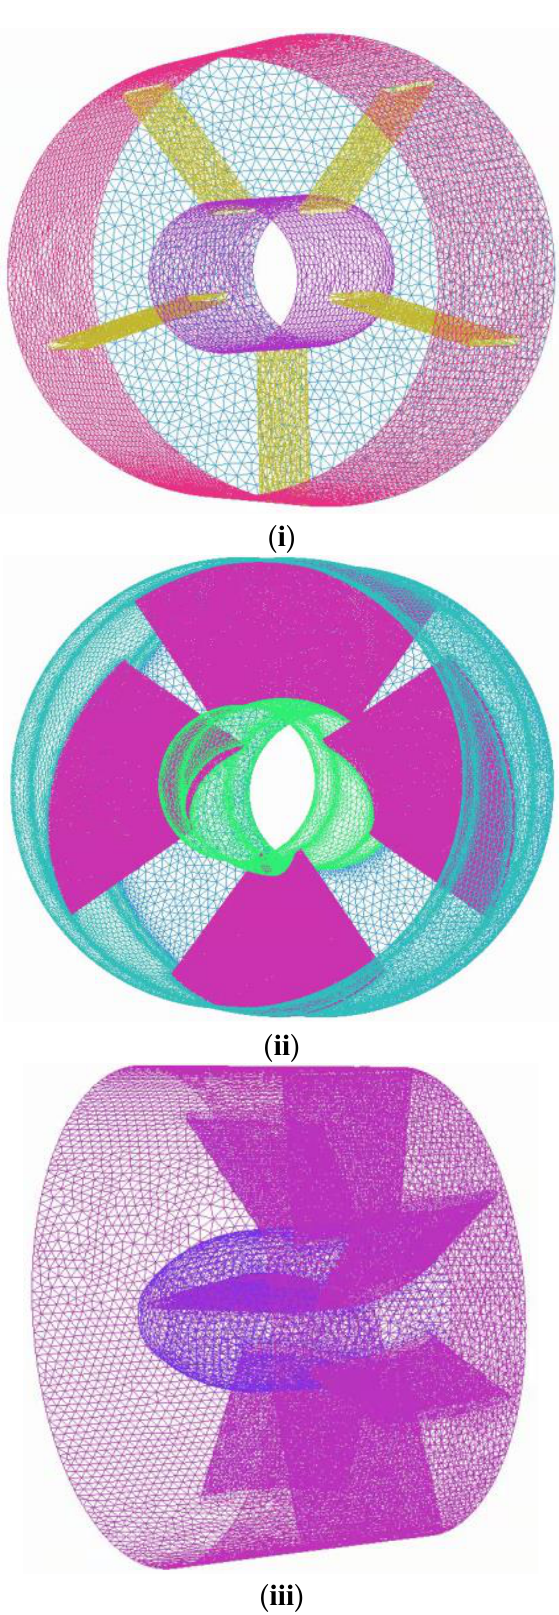
Figure 3. Meshing of the axial-flow pump fluid domain. ( ⅰ ) Front guide vane area. ( ⅱ ) Turbine blade region. ( ⅲ ) Active guide vane region.